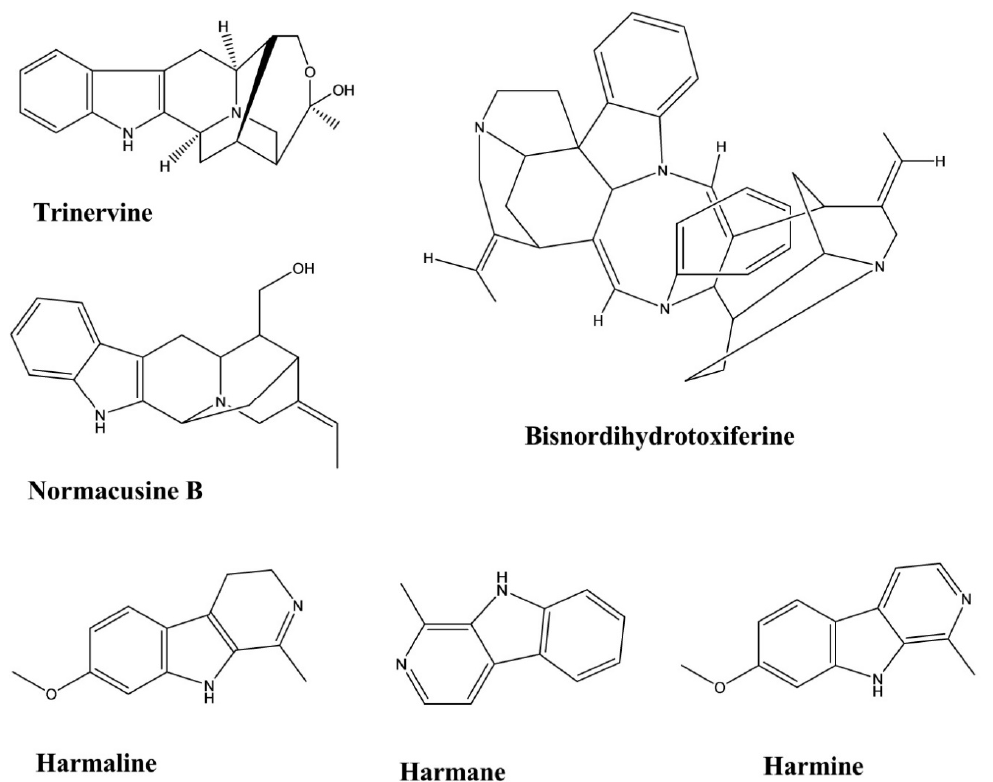
Figure 15. Spasmolytic activity of indole alkaloids.